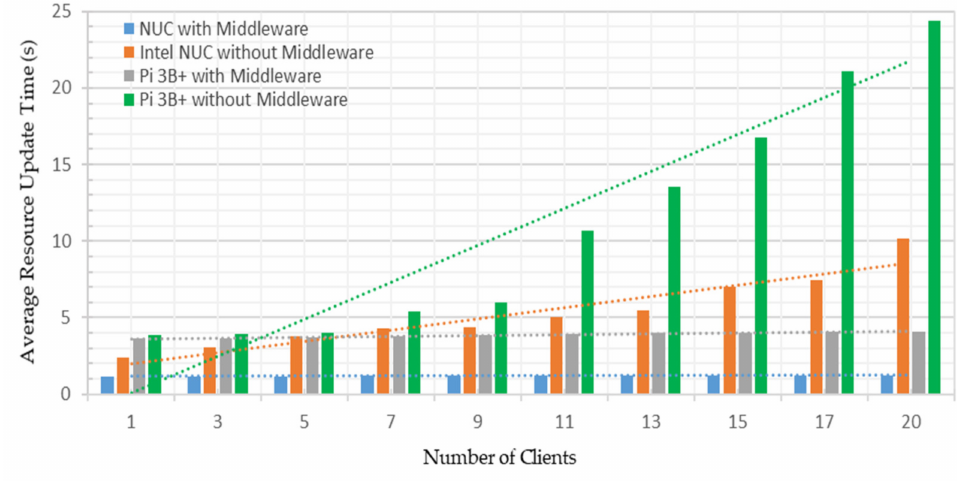
Figure 22. Average OPC UA server resource update interval time with varying